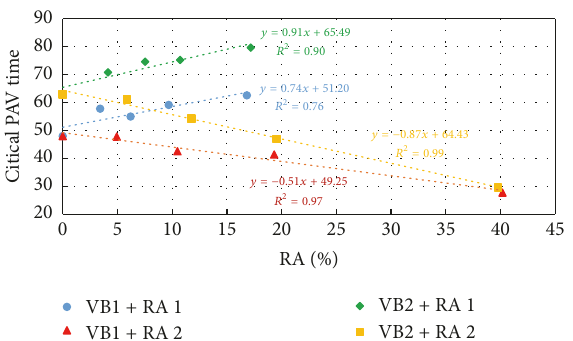
Figure 6: Rise of high PG in each stage of PAV aging.